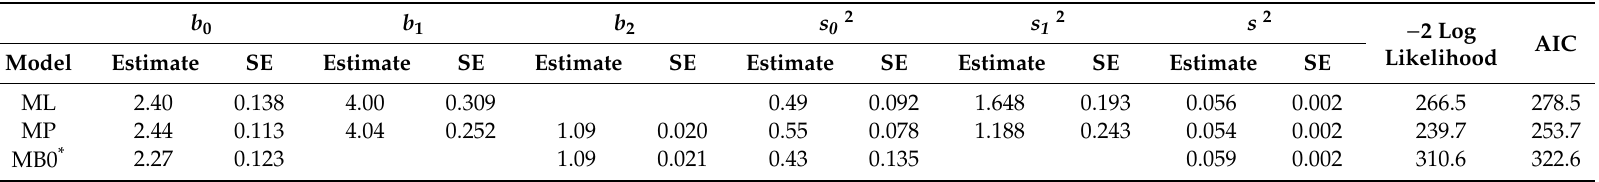
Table 4. Parameter estimates, standard errors (SE) and fit statistics for crown profile models ML (Equation (10)), MP (Equation (11)) and MB0 (Equation (12)) for western